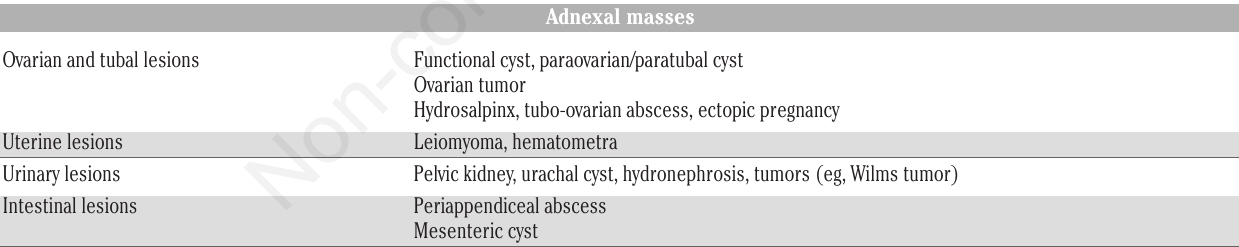
Table 2. Differential diagnoses of adnexal masses in the pediatric age.